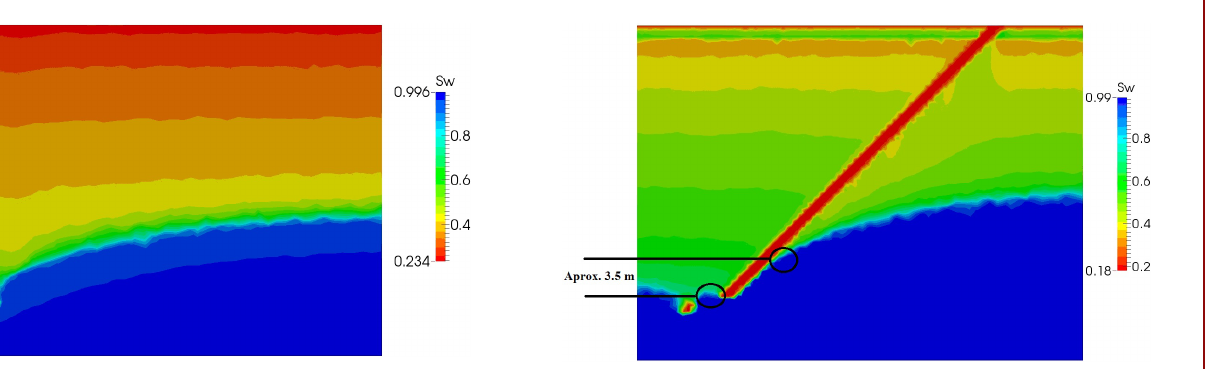
Figure 3. Water saturation after water extraction of a single system without fracture.